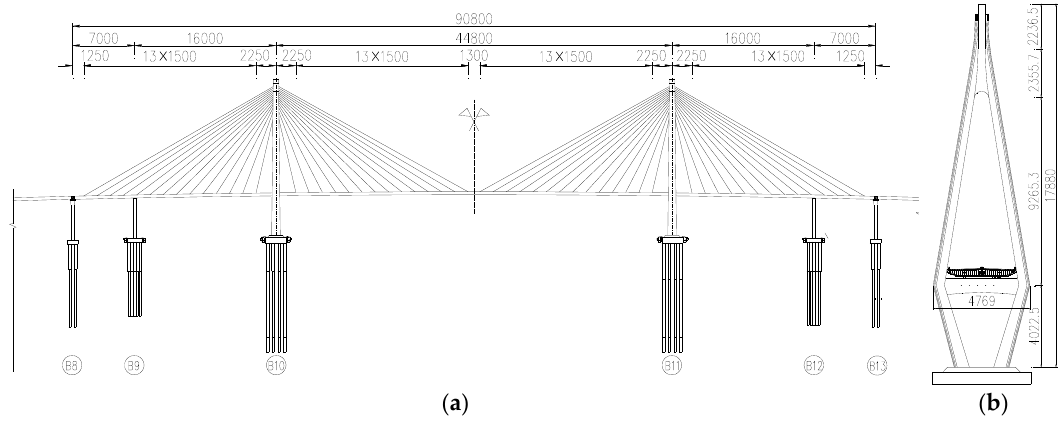
Figure 3. Cross-section of girder (Unit: mm).